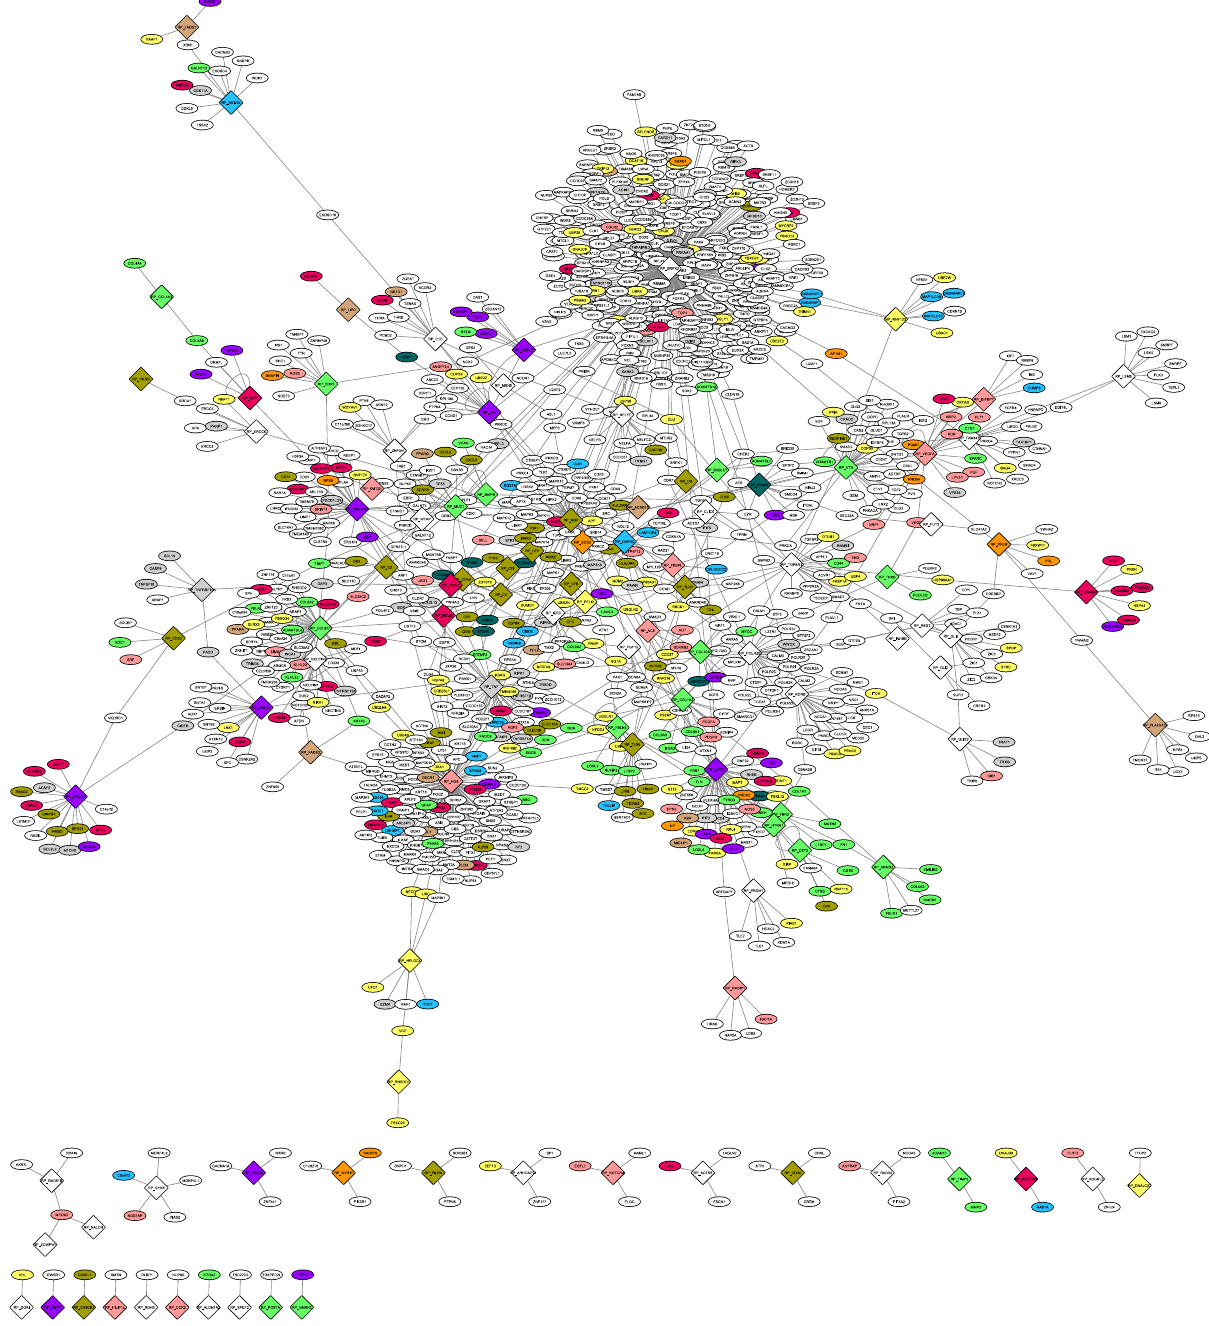
Fig. 4 Overall topology of the binary quantitative AMD network. AMD-risk proteins are represented as diamonds and interacting proteins that are not AMD-risk proteins are shown as ellipse. Nodes are colored according to the ten homeostasis functions using the same color code as before. Cell death functions are indicated in gray and all other functions in white. For additional details see Data Availability Supplementary File 4 (can be viewed using Cytoscape